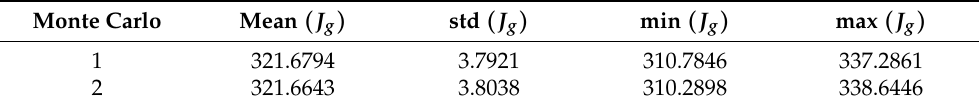
Figure 12. Results of Monte Carlo simulations. Table 1. Summary of the performances of Monte Carlo simulations (only the feasible solutions are